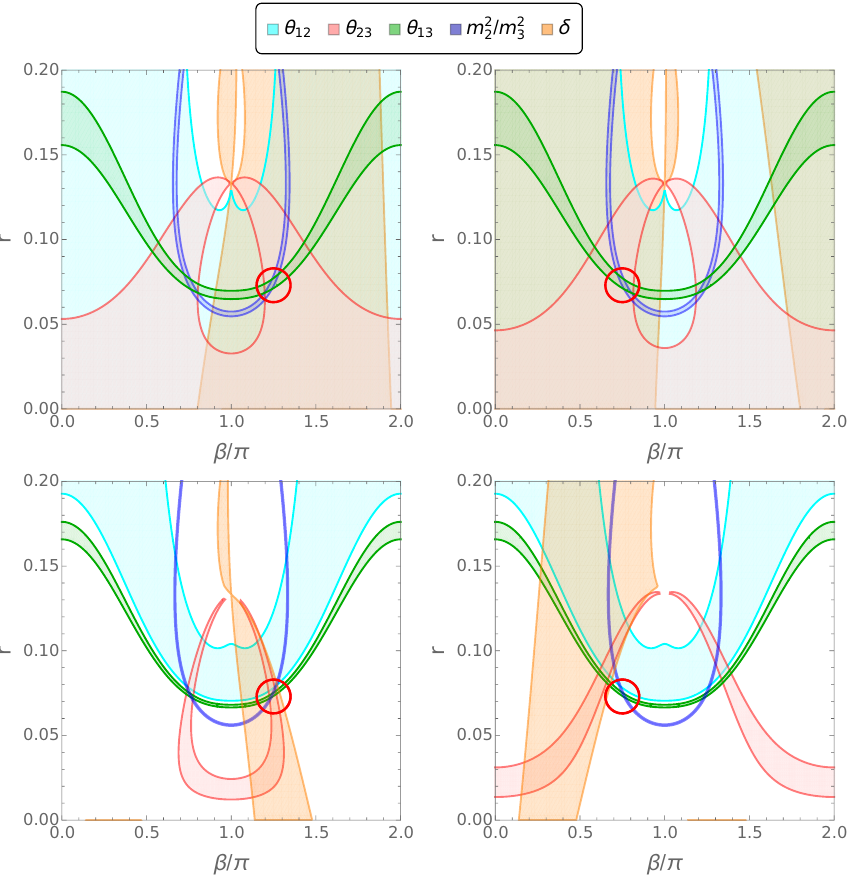
Figure 2 . As in figure 1 but using the NuFit 5.1 values with SK atmospheric data. Left: n = √ √ 1 + 6 , right: n = 1 − 6 , top: 3 σ , bottom: 1 σ